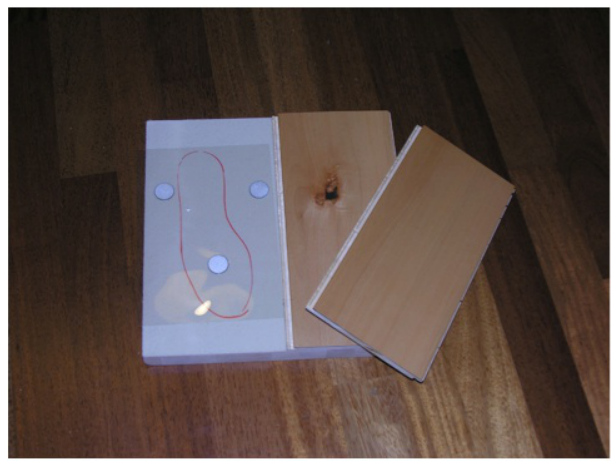
Figure 13. Capacitive sensors on polymeric support installed between solid wood and wooden part of a floating floor.